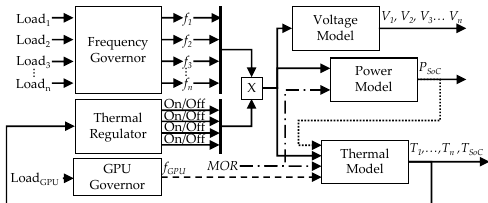
Figure 1. General diagram of the proposed incremental modeling of an embedded system-on-chip (SoC). MOR: Memory Occupation Rate.